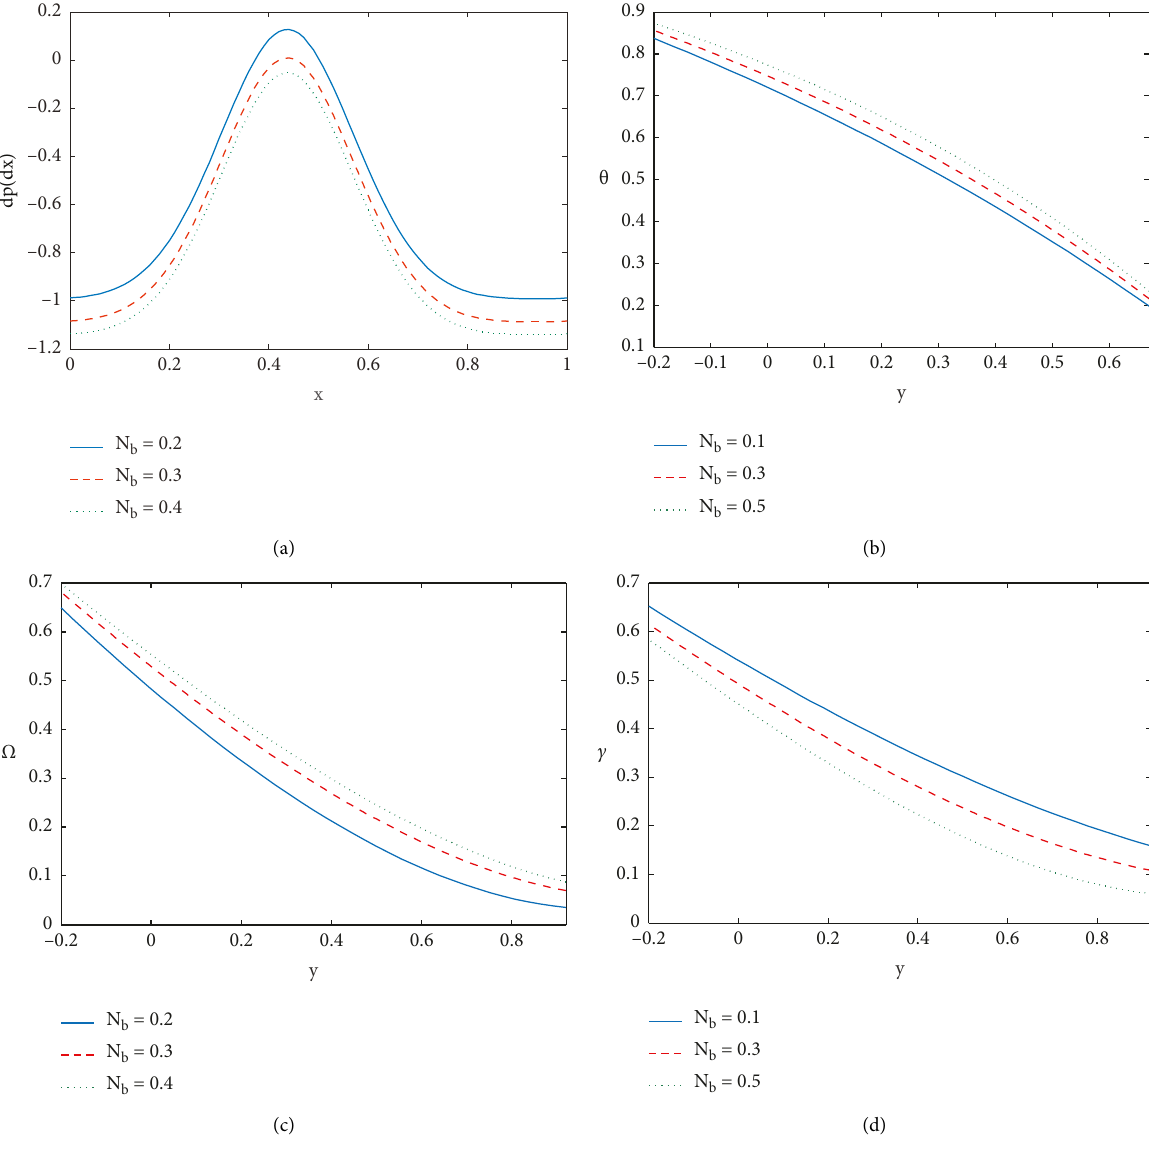
dp / dx , θ , Ω , and c b on